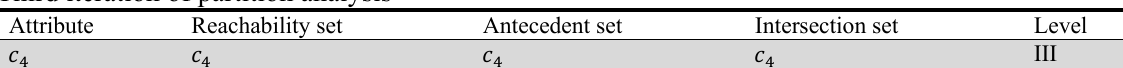
Third iteration of partition analysis